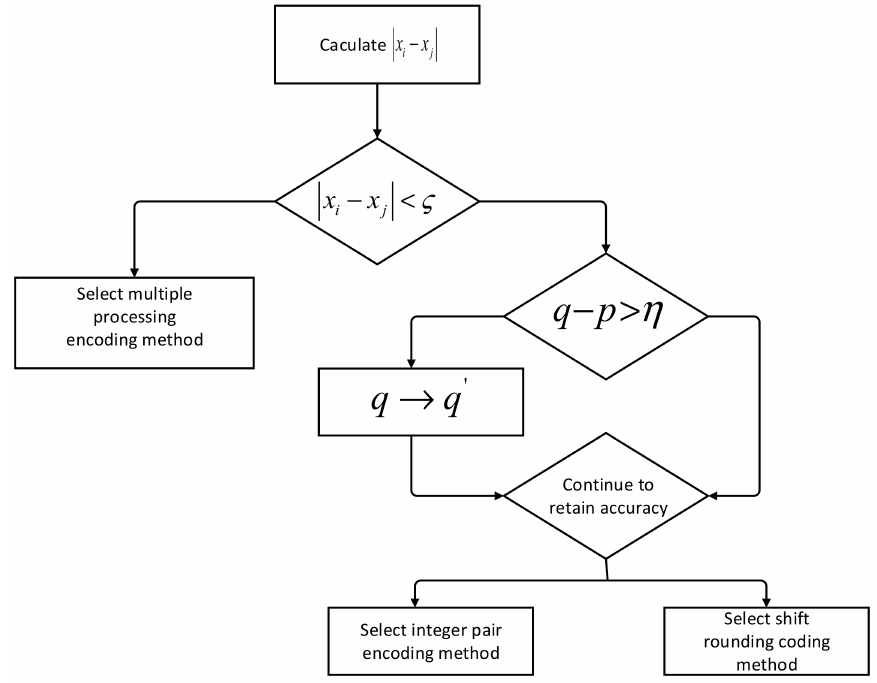
Figure 3. Selection process of pre-processing method.